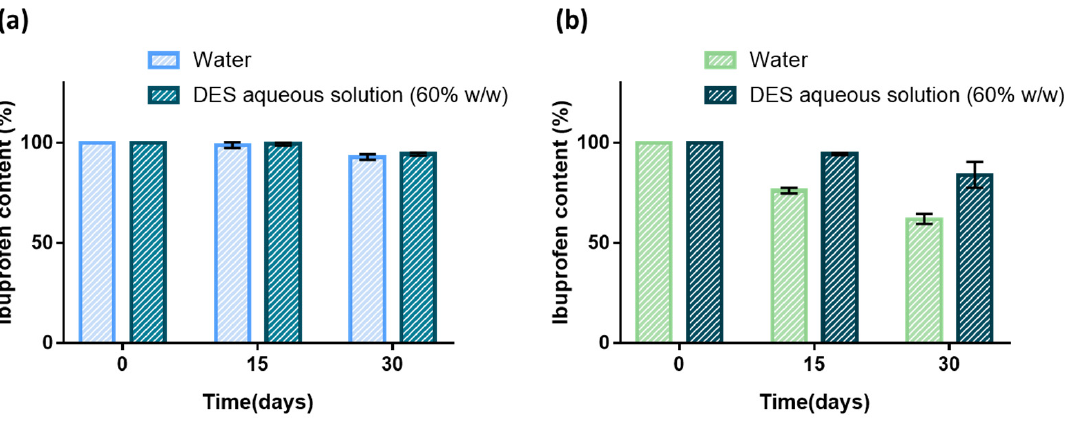
Figure 3. Effect of the solvent in the stability of ibuprofen at 25 °C ( a ) and 37 °C ( b ) over a period of 30 days. The results are expressed as the mean ± SD of three independent experiments.